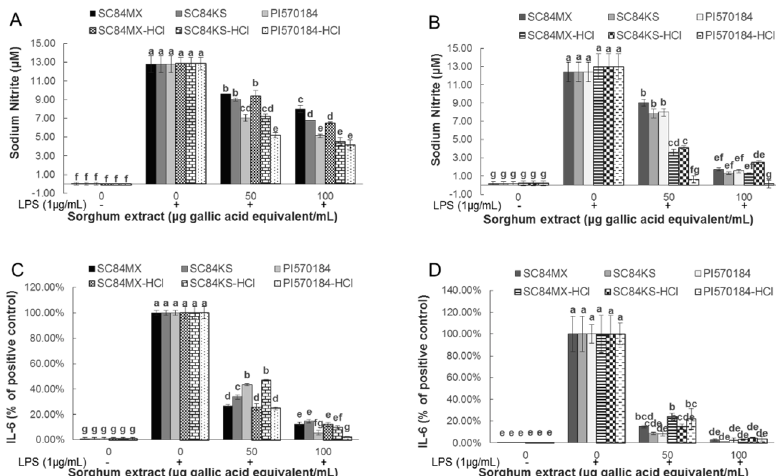
Figure 3. E ff ects of sorghum phenolic extracts on NO and interleukin (IL)-6 production in LPS-induced RAW 264.7 macrophages. NO production by macrophages as a ff ected by LPS and sorghum ( A ) water extracts and ( B ) ethanol extracts; IL-6 production as a ff ected by LPS and sorghum ( C ) water and ( D ) ethanol extracts. Percentage production of IL-6 was calculated with respect to the positive control. Error bars are standard deviations ( n ≥ 3). Di ff erent letters above columns indicate significant di ff erences ( p <